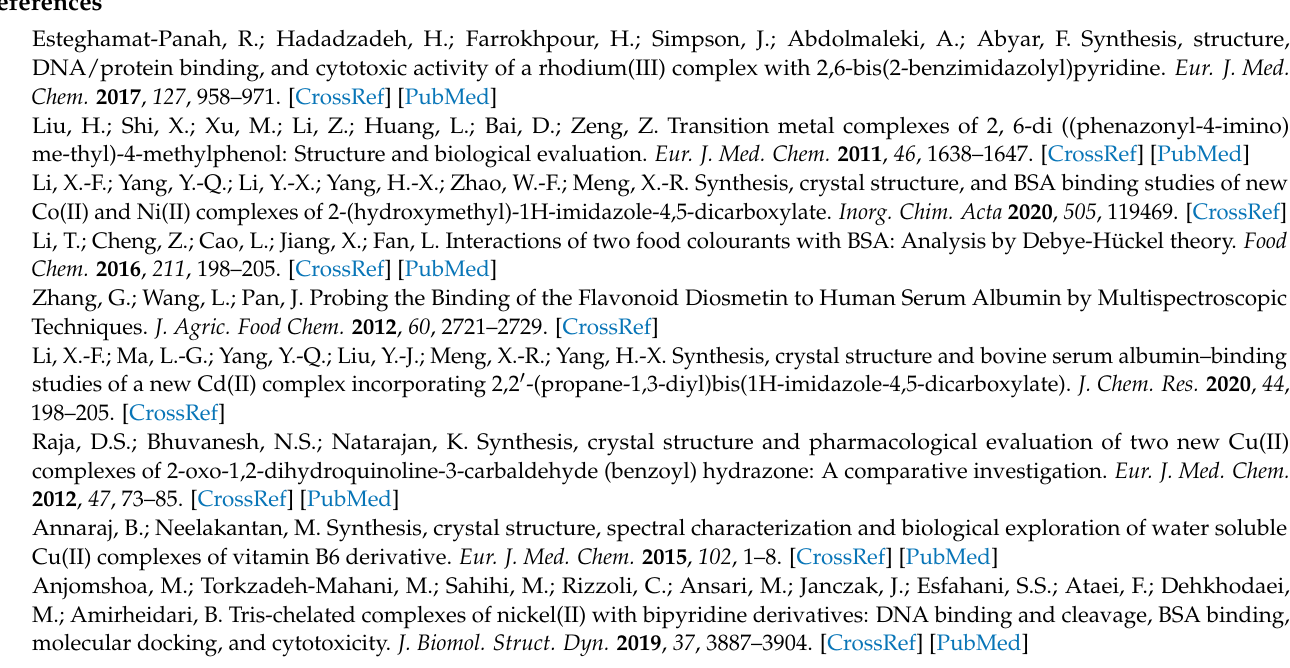
at 298 K ( a ), 308 K ( b ), and 313 K ( c ). Arrow shows the emission intensity changes upon the increasing concentration of complex 2 . Figure S11: The Stern–Volmer curves for quenching of complex 1 with HSA at 298 K ( a ), 308 K ( b ), and 313 K ( c ). Figure S12: The Stern–Volmer curves for quenching of complex 2 with has at 298 K ( a ), 308 K ( b ), and 313 K ( c ). Figure S13: Double-log plots of complex 1 quenching effects on HSA fluorescence at 298 K ( a ), 308 K ( b ), and 313 K ( c ). Figure S14: Double-log plots of complex 2 quenching effects on HSA fluorescence at 298 K ( a ), 308 K ( b ), and 313 K ( c ). Figure S15: Synchronous fluorescence spectra of HSA in the presence of increasing amounts of com- plex 1 at ∆ λ = 15 nm ( a ) and at ∆ λ = 60 nm ( b ). Arrow shows the emission intensity changes upon the increasing concentration of complex 1 . Figure S16: Synchronous fluorescence spectra of HSA in the presence of increasing amounts of complex 2 at ∆ λ = 15 nm ( a ) and at ∆ λ = 60 nm ( b ). Arrow shows the emission intensity changes upon the increasing concentration of complex 2 . Figure S17: 1 H NMR spectra of complex 1 . Figure S18: 1 H NMR spectra of complex 2 . Figure S19: IR spectra of complex 1 . Figure S20: IR spectra of complex 2 . Cif data and checkcif for complexes 1 and 2